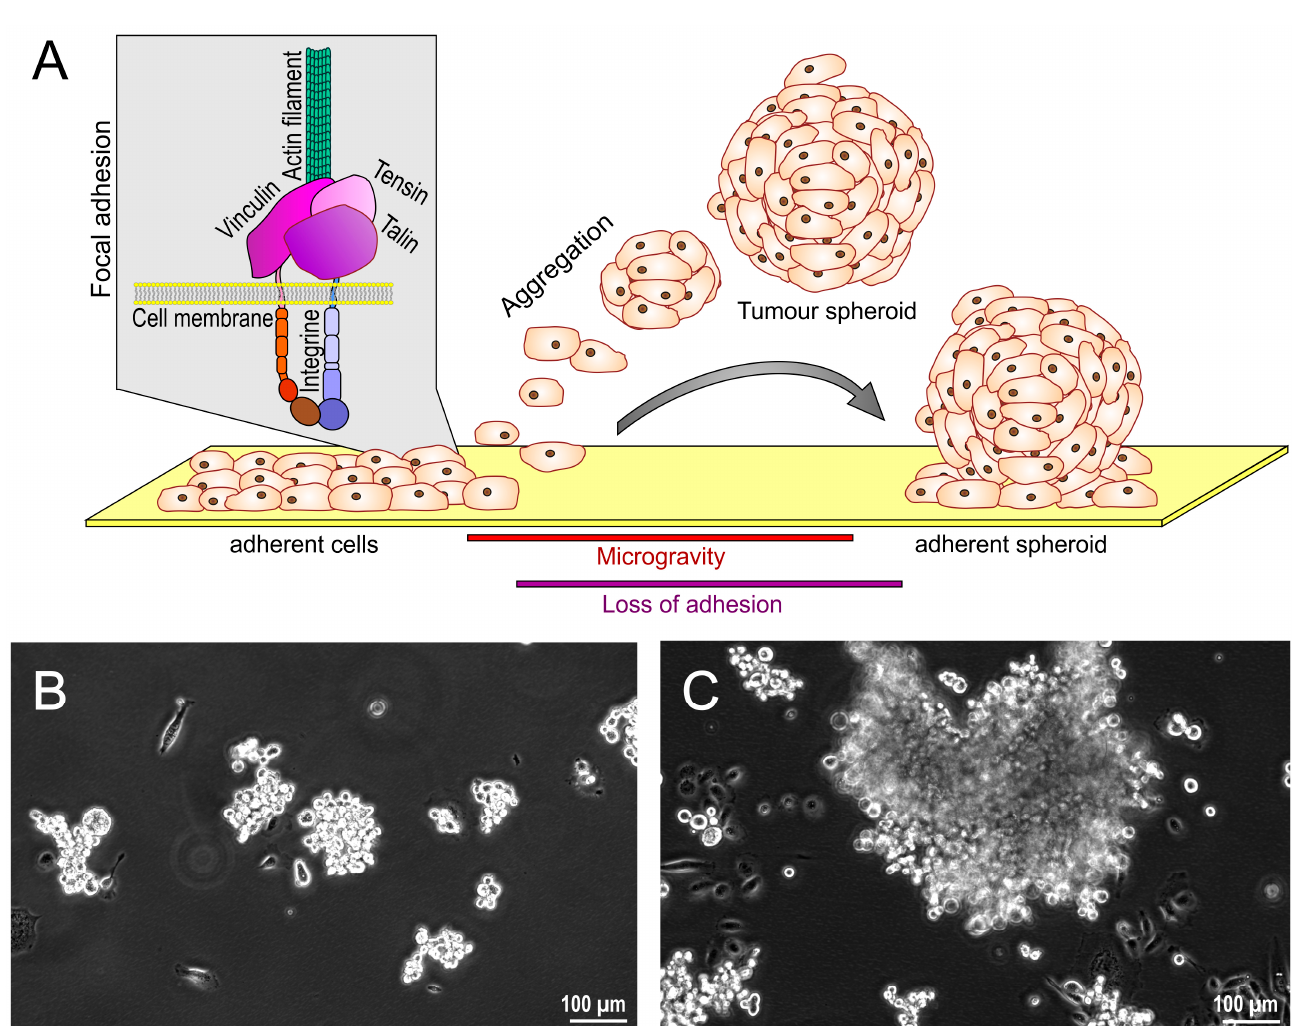
Figure 4. Microgravity-induced in vitro metastasis model. ( A ) µ g exposure of adherent tumor cells causes downregulation of focal adhesion molecules. As a consequence, cells detach and form tumor spheroids resembling micrometastases. When gravity is restored, the spheroids reattach to their substrate. ( B , C ) Transmitted light microscopy images of spheroid development in PC-3 prostate tumor cells under s-µ g (RPI). The graphical representation of cell adherence and spheroid formation is inspired by Grimm et al., 2022, Figure 5 [214] .